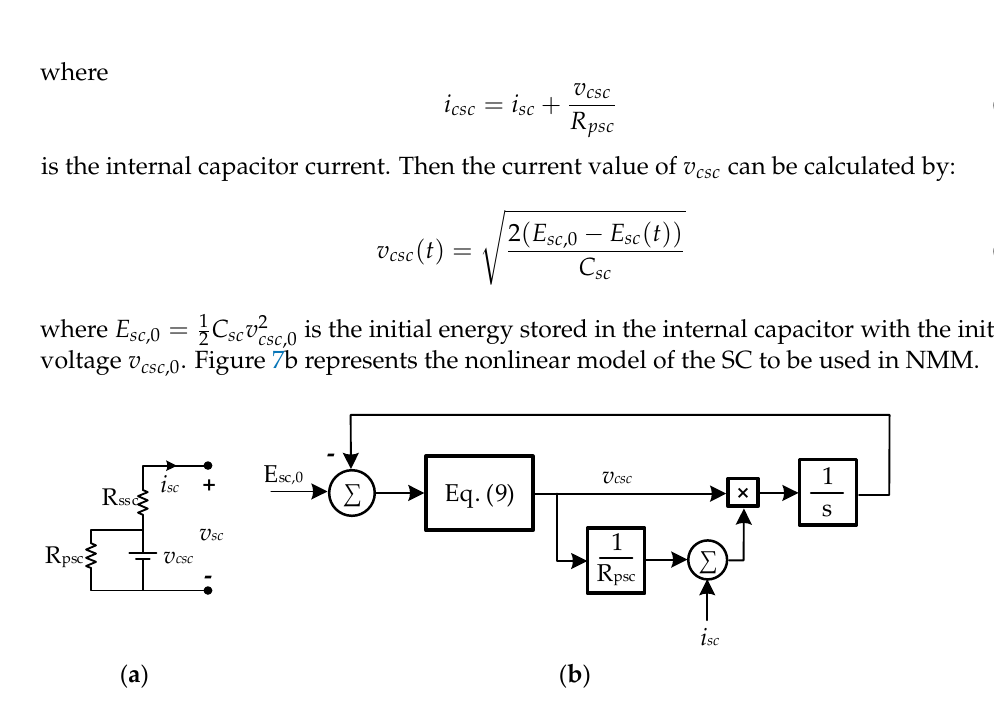
Figure 7. Supercapacitor model, ( a ) circuit model, and ( b ) nonlinear model diagram.